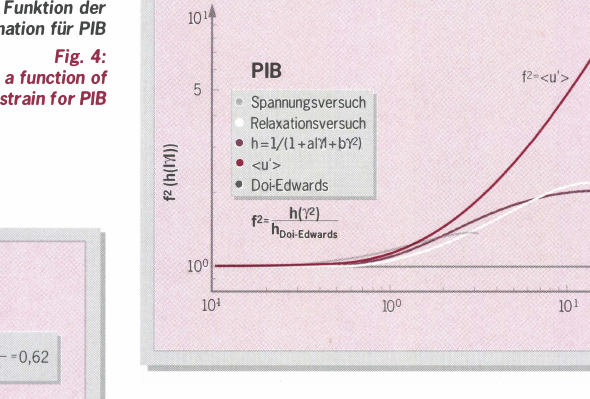
Fig. 5: A as a function of the time difference t, for type C experiments